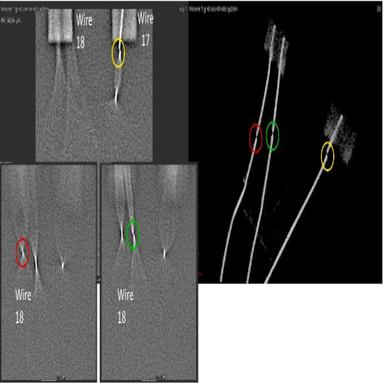
CT X-ray images of the wire bond connections 17 and 18 of a sample after 500 TC.